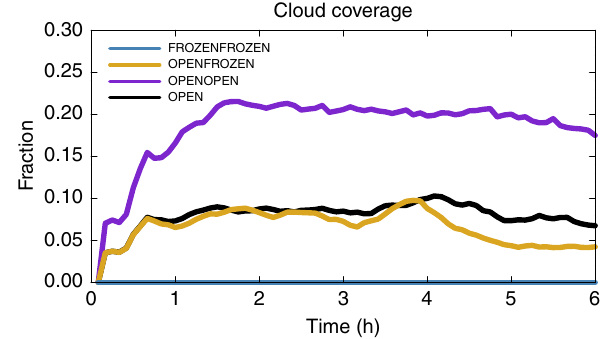
Fig. 4 Time series of cloud coverage. Time series of the cloud coverage from the OPEN (black), OPENOPEN (purple), OPENFROZEN (orange), and FROZENFROZEN (blue) cases. The cloud coverage is de fi ned as the fraction of grid points with radiatively signi fi cant clouds for the entire